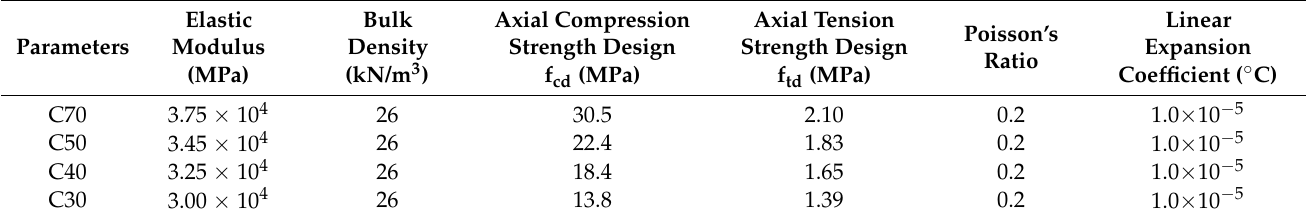
Table 1. Properties of concrete used in this study.